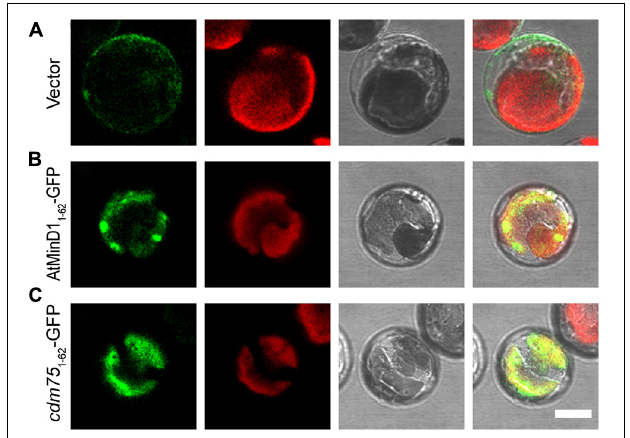
FIGURE 7 | Proposed working model of the role of AtMinD1 in the onset of Z-ring positioning in chloroplasts. Model shows the topologies, interactions, and functional relationships of AtMinD1 with ARC6, FtsZ1, FtsZ2, MCD1, ARC3, AtMinE1, and PARC6 based on our genetic, cytological, and molecular data, emphasizing the role of AtMinD1 in the Min system. In this model, ARC6 interacts with FtsZ2 to tether heteropolymers (Z filaments) of FtsZ1 and FtsZ2 to the chloroplast inner envelope membrane (IEM), and PARC6 acts downstream of ARC6 to interact with FtsZ2 CTP to tether the Z filaments. The subsequent interaction between MCD1 and ARC6 through their stromal regions results in the recruitment of MCD1 to FtsZ heteropolymers coupled to ARC6 in the membrane. Coincidentally, AtMinD1 is enlisted and brought near chloroplasts, and then transferred to the stroma by cutting the transfer peptide. Subsequently, AtMinD1 is recruited by MCD1, and combines with ARC3 on the FtsZ heteropolymers and, in one of the most important steps of this process, AtMinD1 interacts with ARC6, permitting ARC3 to act in the disassembly of FtsZ filaments. In this process, the AtMinD1 NCTS motif plays a core role in the interaction, forming the chloroplast division complex and regulating the chloroplast division process. Finally, sufficient data exist in previous studies to affirm that AtMinE1 spatially restricts the activity of this inhibitory complex of MCD1, AtMinD1, and ARC3 via an unknown mechanism, although AtMinE1 might interact with AtMinD1 directly, resulting in Z-ring assembly. Many details of this model remain to be elucidated. The proteins shown do not represent stoichiometric ratios. OEM, outer envelope membrane; IMS, intermembrane space; N, N-terminus; C,